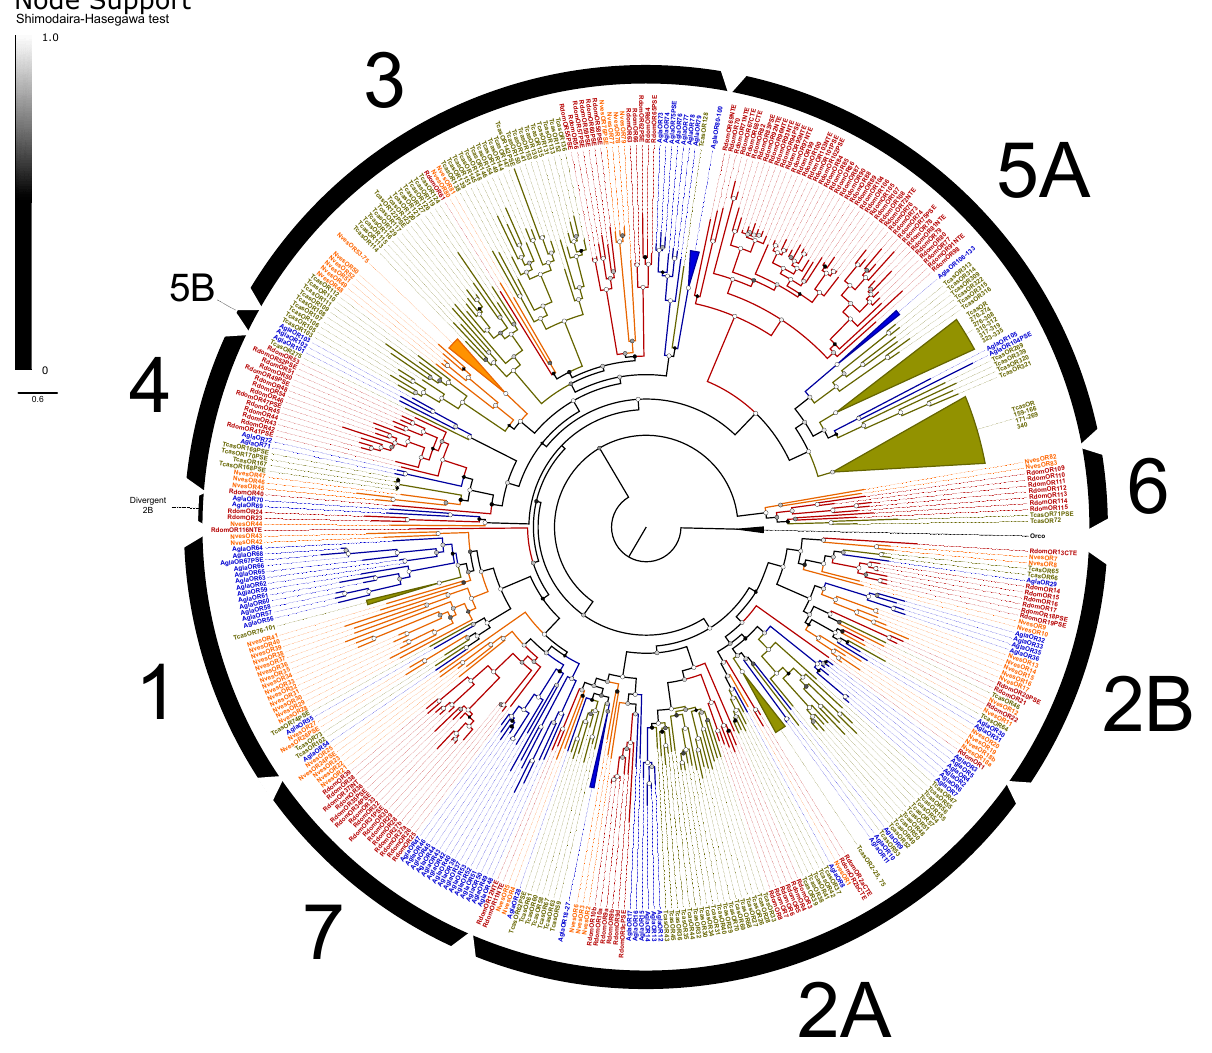
Figure 3. Phylogeny comparing odorant receptors (ORs) of Rhyzopertha dominica (red) to those of Anoplophora glabripennis (blue), Tribolium castaneum (yellow), and Nicrophorus vespilloides (orange), rooted with the conserved co ‐ receptor Orco lineage. Colored circles at nodes represent Shimodaira ‐ Hasegawa support values, shaded from black (0–0.5) to white (1.0). Black arcs de ‐ scribe the known subfamilies of coleopteran ORs (1–7). Some large lineage ‐ specific expansions of ORs have been collapsed for clarity; identities of the removed genes are listed next to the collapsed sector. ORs of R . dominica sorted into the expected lineage ‐ specific expansions among the larger OR subfamilies [66], though Group 2A appears paraphyletic, and a divergent group of 2B genes (including RdomOR23–24) are misplaced due to the limited gene set used to construct these phylogenies (Figure 3). The largest expansion (RdomOR67–108) emerged in Group 5A, a prolific subfamily previously known only from cucujiform beetles [34]. No members of Group 5A have been functionally characterized, but the subfamily includes over 150 members in T . castaneum , where their expression is strongly associated with mouthparts [103]. R . dominica also presented a large radiation of ORs in Group 4 (RdomOR40–54), which was previously notable as the only coleopteran OR subfamily lacking such radiations.